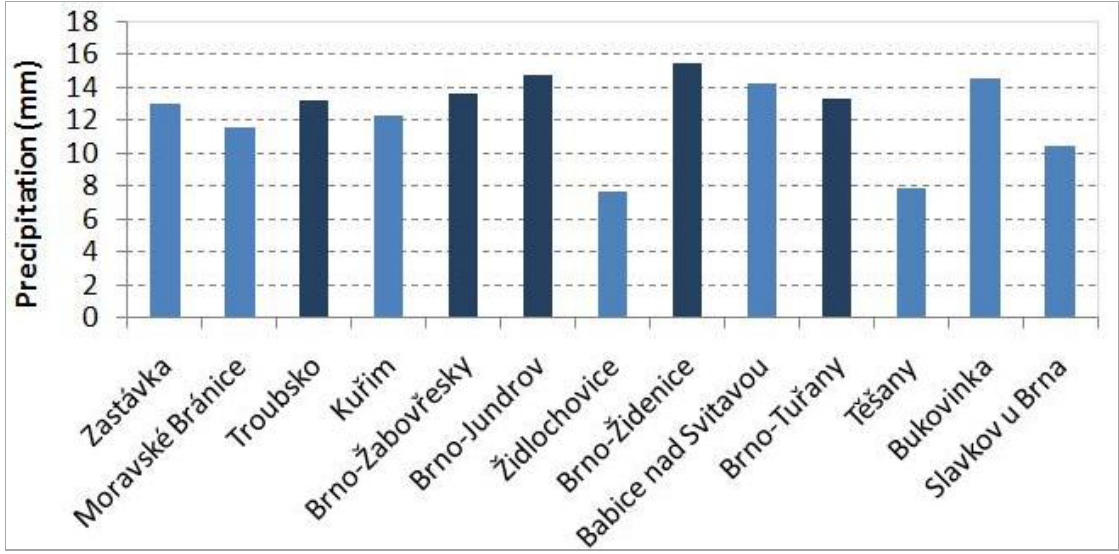
Fig. 6. Daily rainfall totals average in the days of torrential rain in Brno